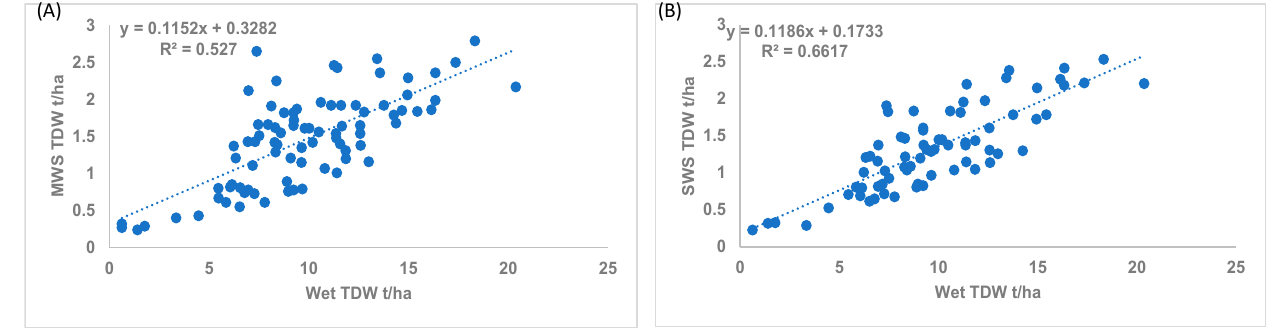
efficiency (WUE), Stress tolerance index (STI).